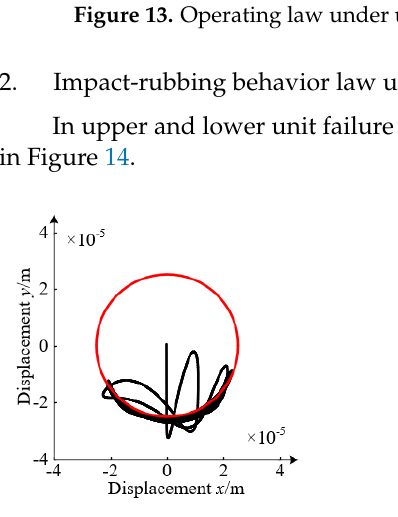
periodic closed circle from the outside to the inside, which indicates the displacement